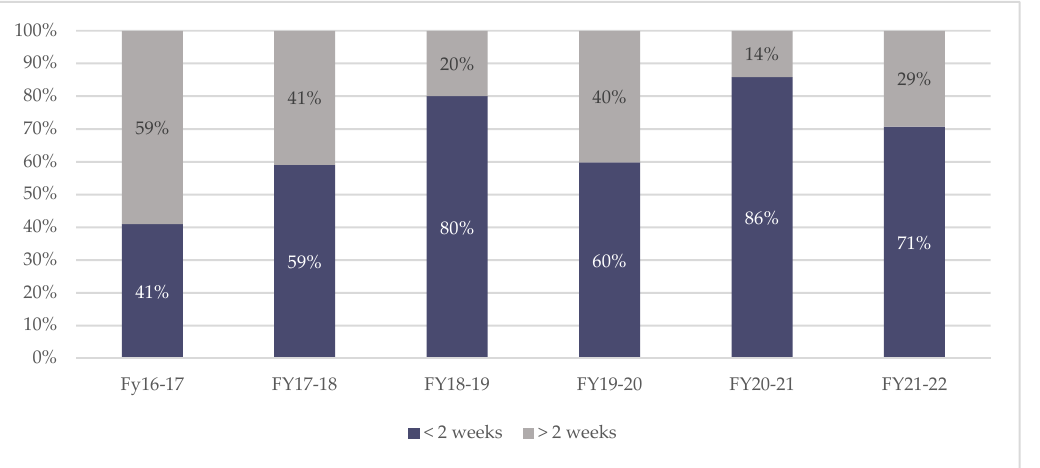
Figure 3. Annual percentage of SMS-NACs completed <2 weeks and >2 weeks from inpatient mobilisation.